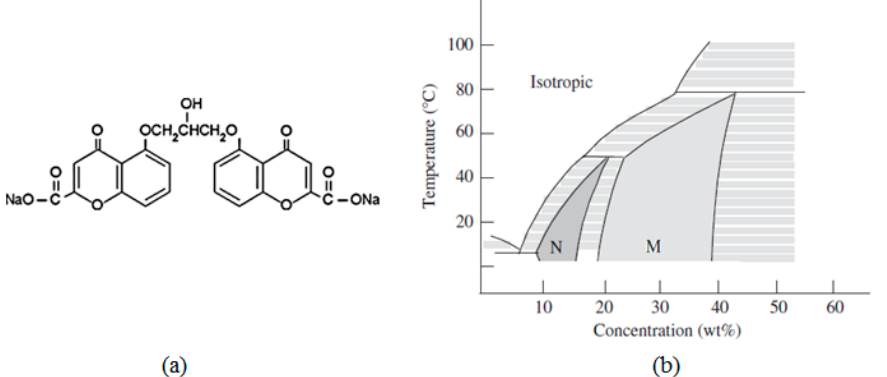
Figure 2. ( a ) DSCG molecular structure and ( b ) its phase diagram. Reprinted with permission from ref. [19]. Copyright 2011, Taylor & Francis.